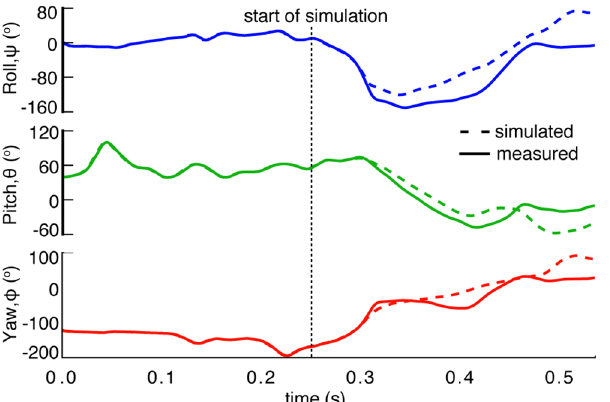
10.5061/dryad.21qs5